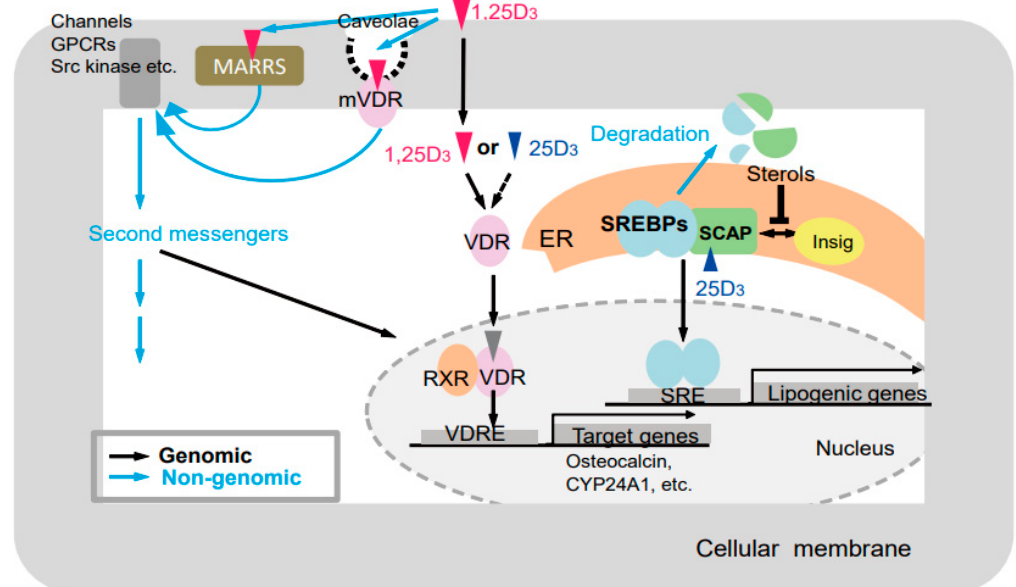
Figure 6. Putative modes of action of vitamin D [25]. Black and blue arrows indicate genomic and nongenomic pathways, respectively. GPCRs, G-protein-coupled receptor; MARRS, (membrane-associated, rapid response steroid-binding) receptor; VDR, vitamin D receptor; mVDR, membrane-bound vitamin D receptor; RXR, retinoid X receptor; VDRE, vitamin D response element; ER, endoplasmic reticulum; SREBPs, sterol regulatory-element–binding proteins; SCAP, SREBP cleavage-activating protein; SRE, sterol regulatory